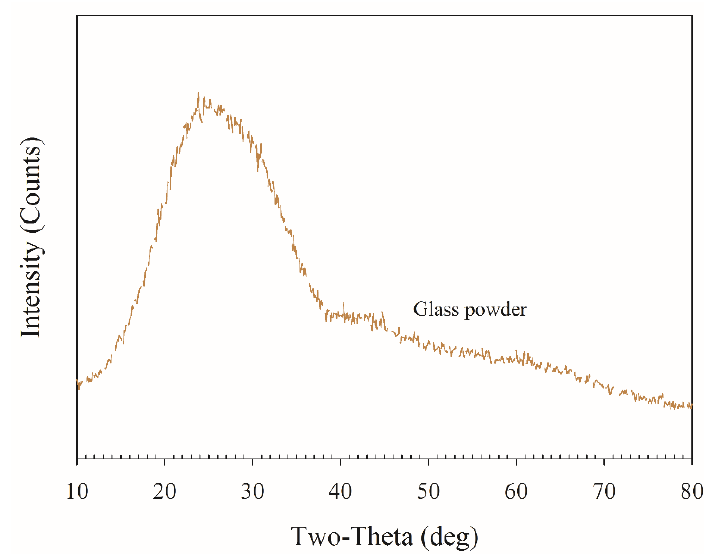
Table 1. Physical and chemical properties of the glass powder produced from waste glass in this study.